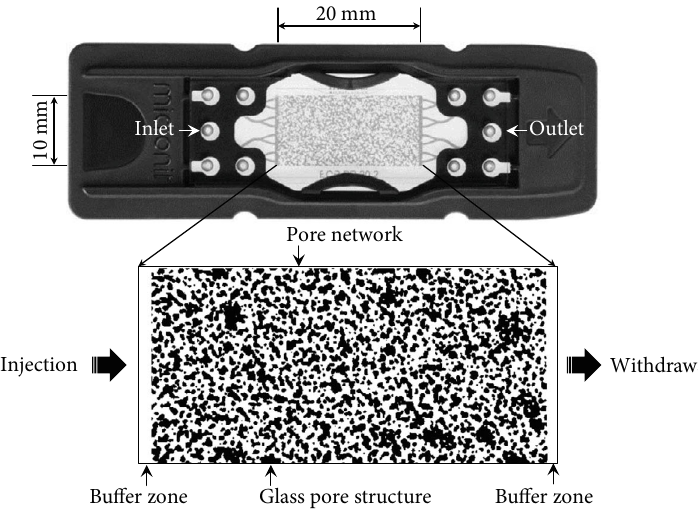
Figure 1: Physical network micromodel and its pore